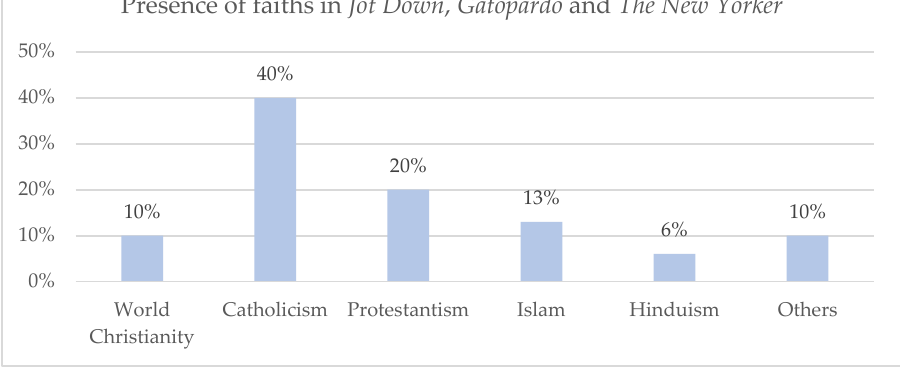
Figure 5. Predominant faiths in articles in Gatopardo . In The New Yorker (Figure 6), Protestantism is the predominant faith (60%) among the topics in which religion is present. It is followed in a much smaller percentage (10%) by Christianity in general, Catholicism, Hinduism, and other religions. According to Gallup (website 2017), in the United States, 48.9% identify as Protestant Christian, 20.8% identify as Catholic, 0.7% identify as Hindu, 0.9%